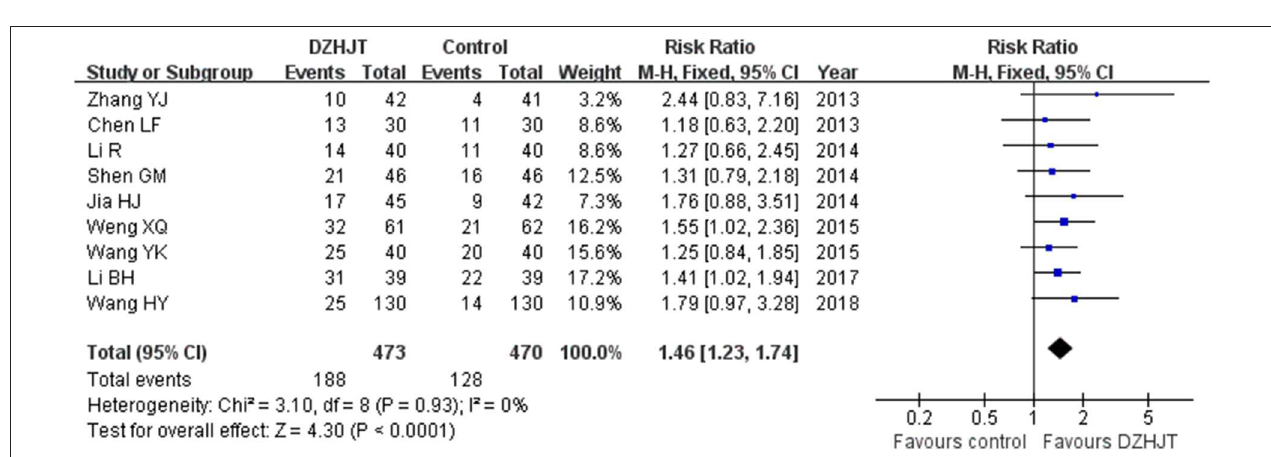
respectively. As shown in Figure 6 , no significant differences were found in headache and dizziness (RR 0.72; 95% CI 0.31–1.67; I 2 = 0%, p = 0.60) between two groups.